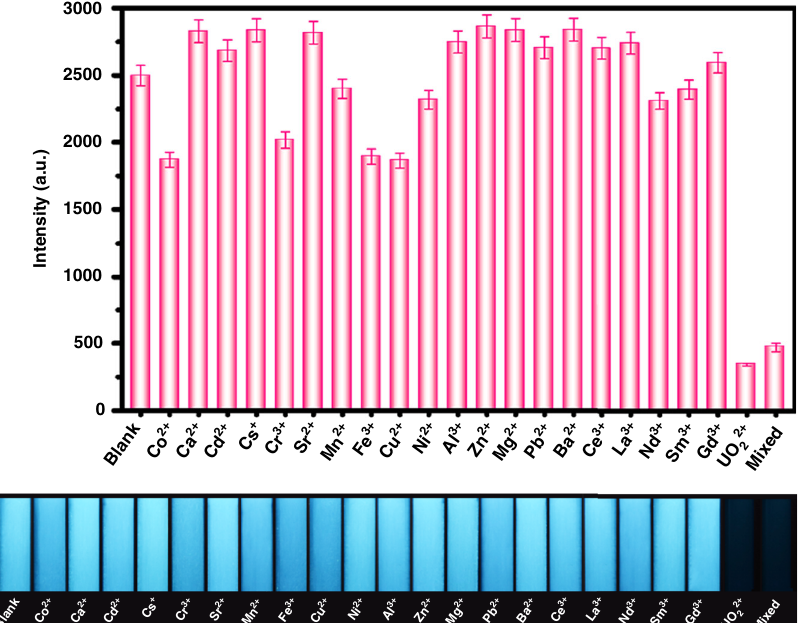
Fig. 3 Selectivity investigations. Fluorescence intensity of TFPT-BTAN-AO at 460nm in the presence of various metal ions and mixed ions. Concentrations of UO 2 2 + and other metal ions were 20 μ M and 50 μ M, respectively. Photographs showing the fl uorescence emission change (under a portable 365nm UV lamp) of TFPT-BTAN-AO with various metal ions. Error bars represent S.D. n = 3 independent experiments.